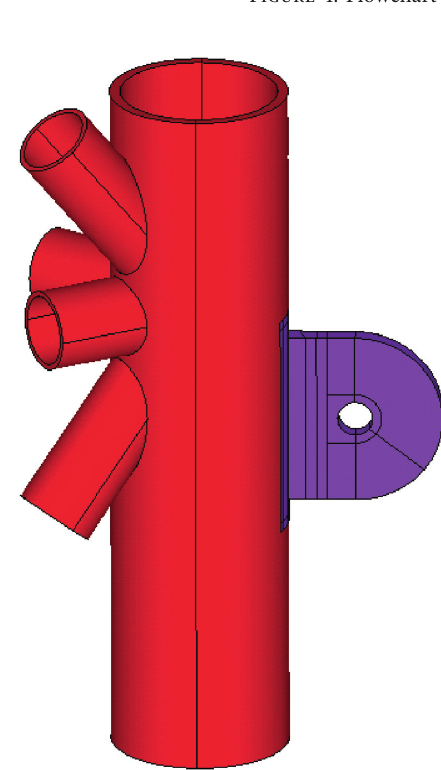
Figure 5: Geometric model of the welded